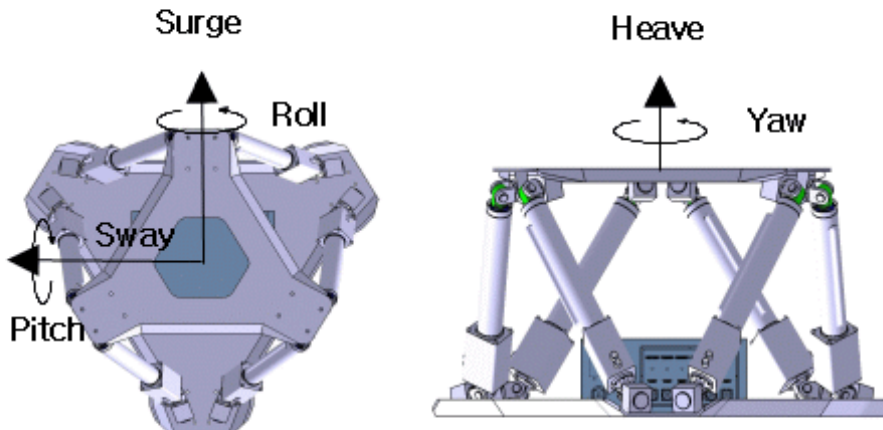
Figure 7. Coordinates of the motion platform.